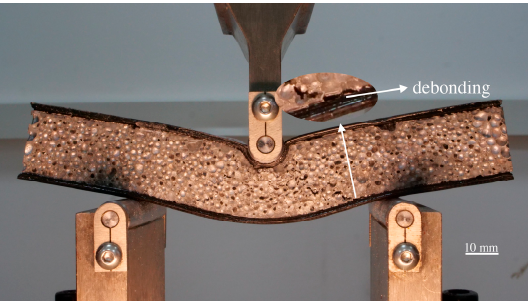
Figure 12. Deformation mode of #20-0.57 at 13.88 mm displacement.